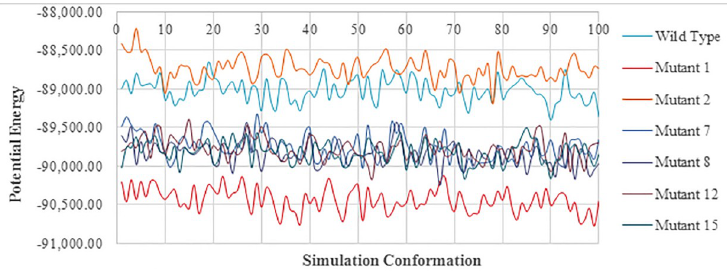
Fig 14. Comparison of Potential energies of scFv-FuBc interaction between wild-type and mutants. Mutant 2 showed higher potential energy as compare to wild type scFv.